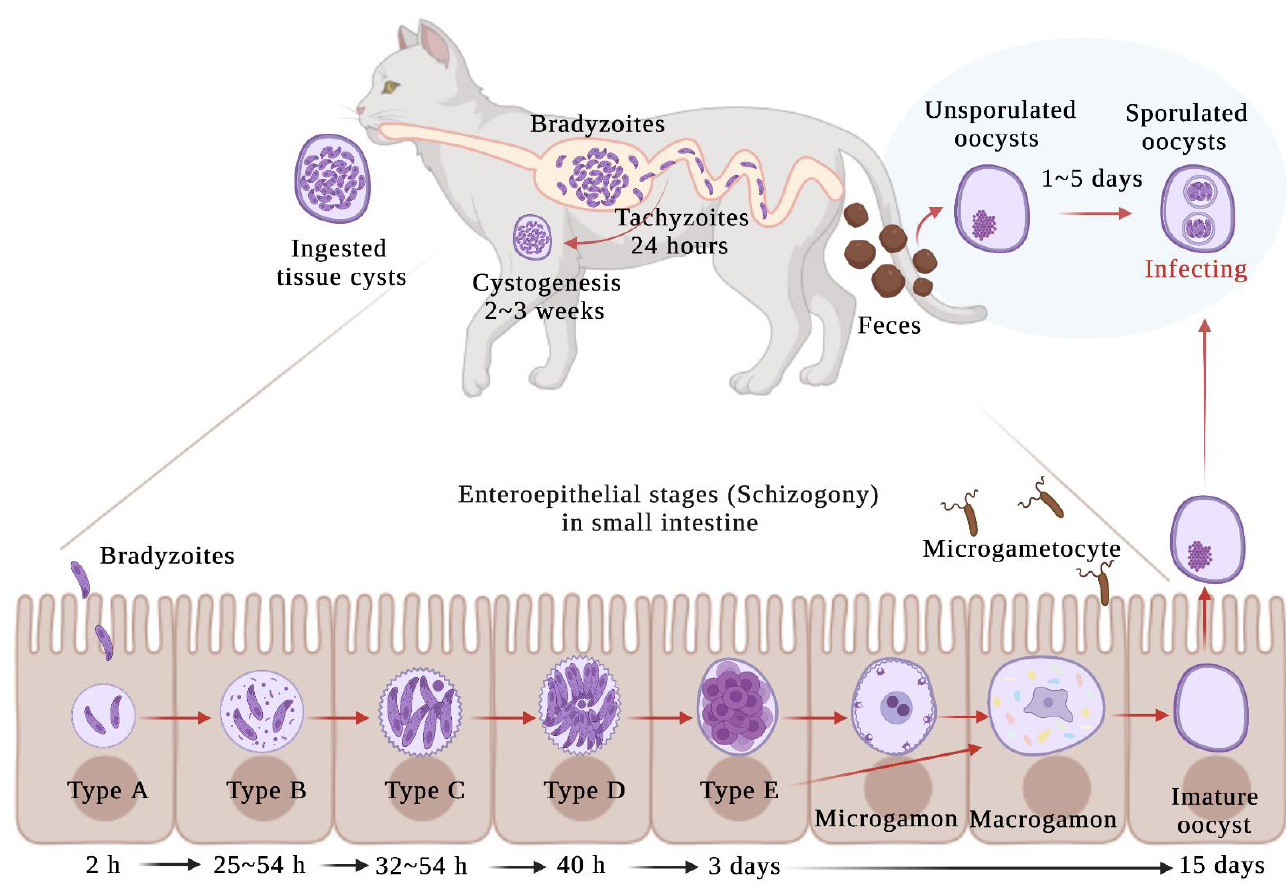
Figure 1. Enteroepithelial stages of T. gondii in epithelial cells of the small intestine from a domestic cat. Schematic based mainly on Moura et al., 2009.